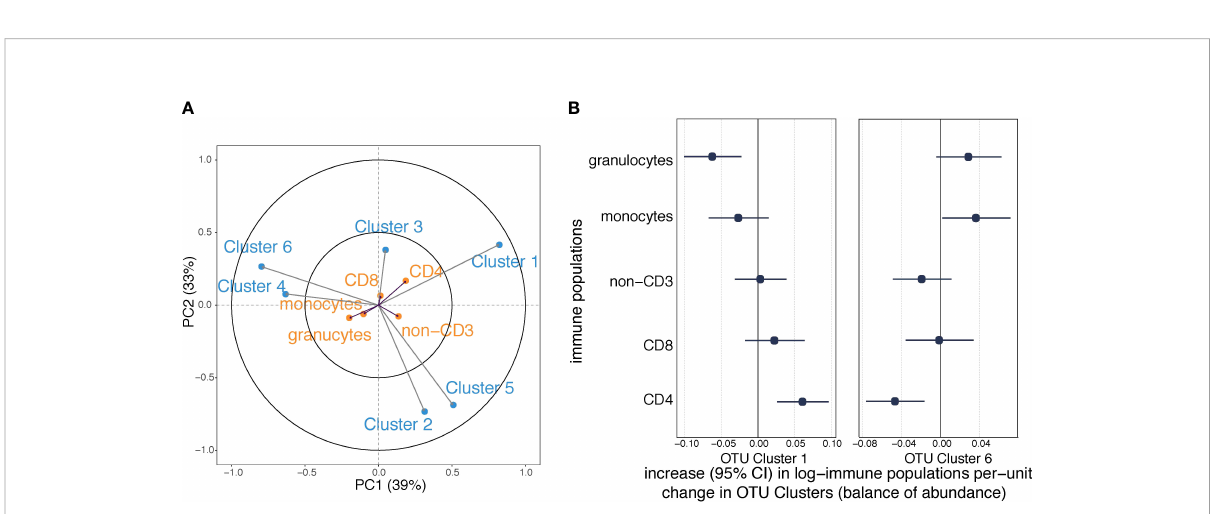
FIGURE 4 Associations between maternal OTU clusters and immune cell pro fi le in cord blood ( n =216). (A) The partial least squares biplot shows the associations between OTU clusters (blue) and immune populations (orange). The acute angle between arrows to Cluster 1 and central naïve CD4+ T cells indicates a positive association, whereas the obtuse angle between Cluster 1 and granulocytes indicates a negative association. (B) Increases (with 95% con fi dence intervals) in log-transformed immune populations per unit change in automated balances for OTU Cluster 1 and 6